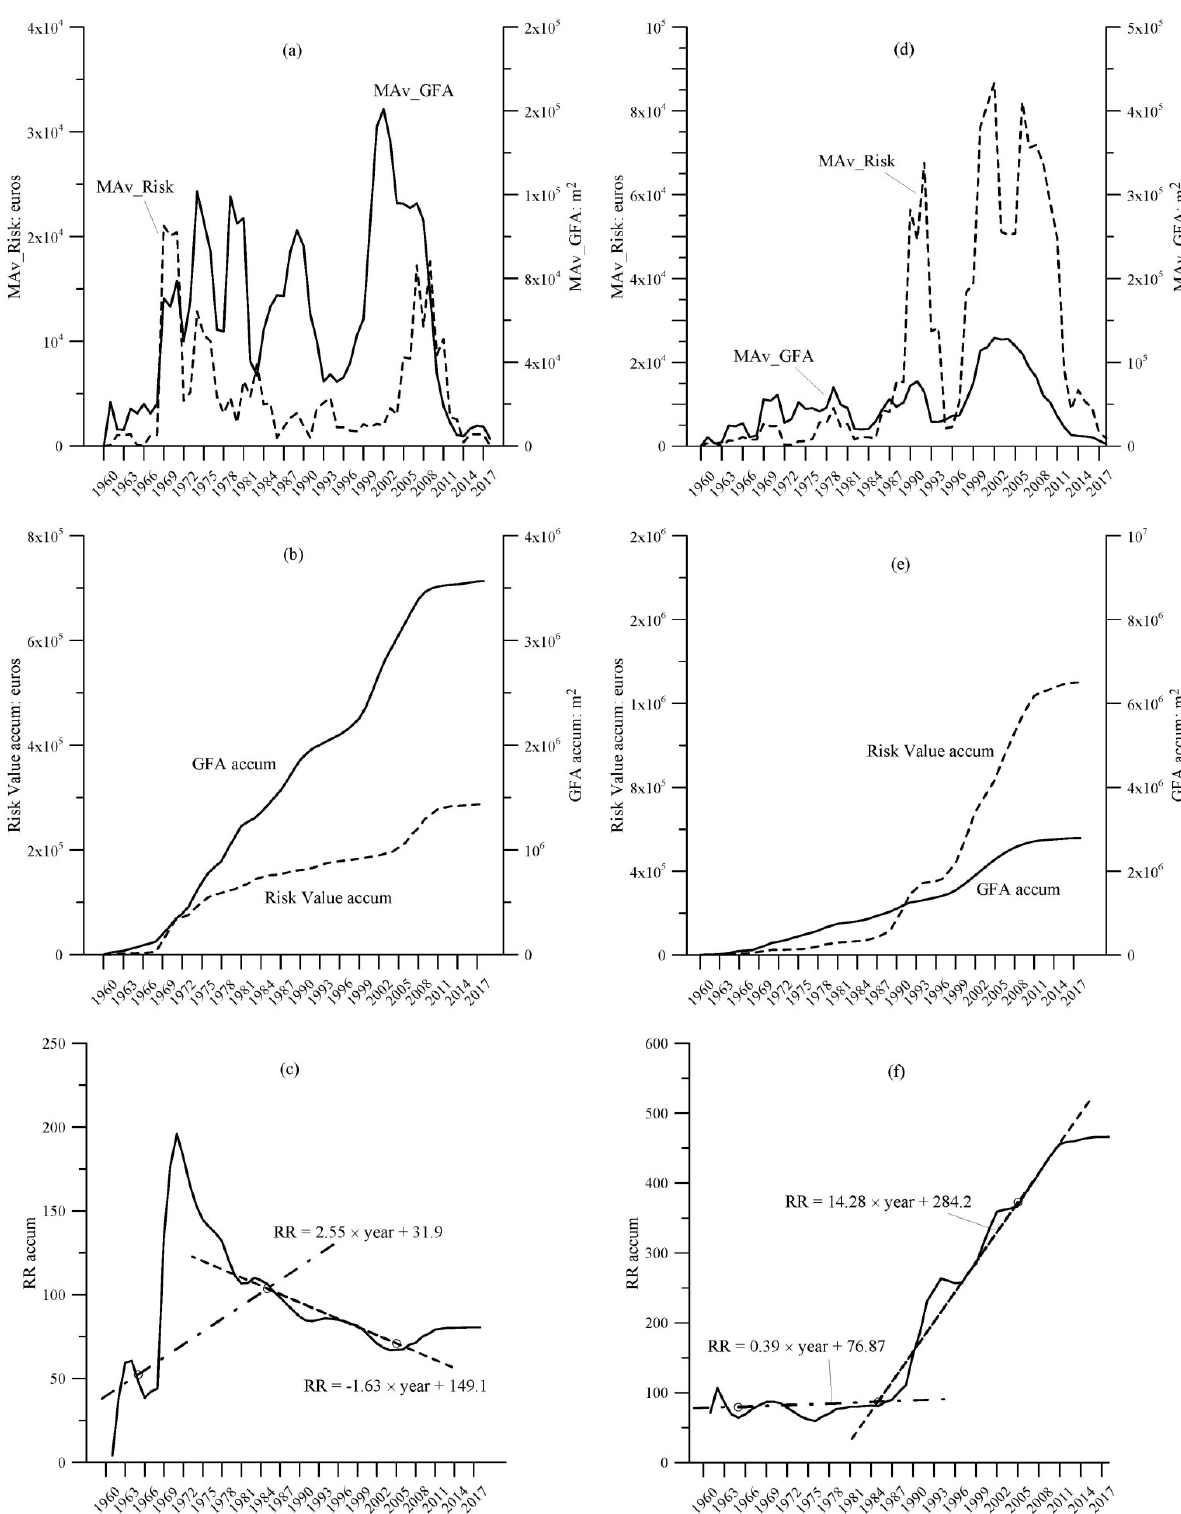
Figure 6. Evolution of the annual series of GFA, RV and RR in the municipalities of Calpe (a–c) and Altea (d–f)